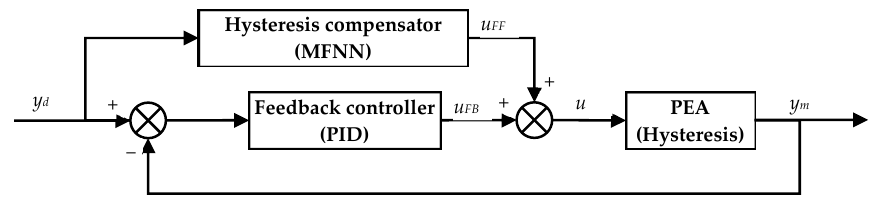
Figure 5. The schematic diagram of the feedforward and feedback combined control.